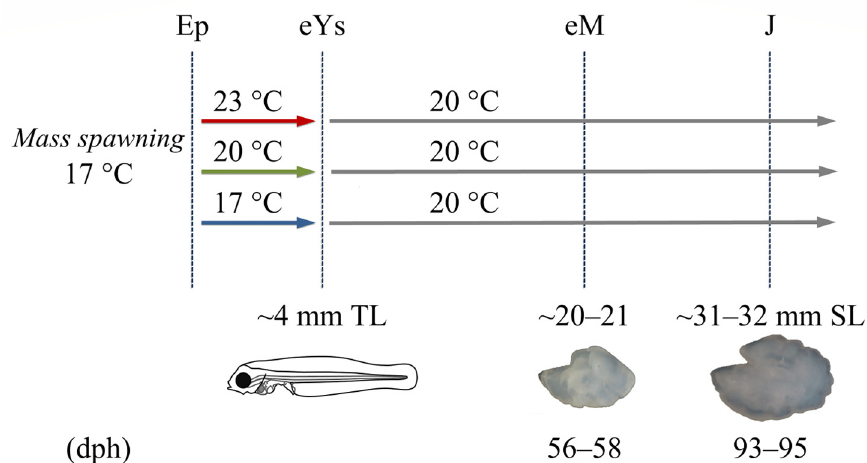
Figure 1. Experimental design. Fish were subjected to one of three developmental temperature treatments (17, 20, or 23 ◦ C) from the epiboly onset (Ep) to the end of the yolk-sac larval stage (eYs, ~4 mm total length, TL) and then to a common temperature up to the juvenile stage (31–32 mm, SL). All thermal treatments were applied in triplicate. Fish otoliths were extracted and analyzed at the end of metamorphosis (eM, 56–58 days post-hatching, dph) and the early juvenile stage (J, 93–95 dph) (modified from Kourkouta et al. [40]).